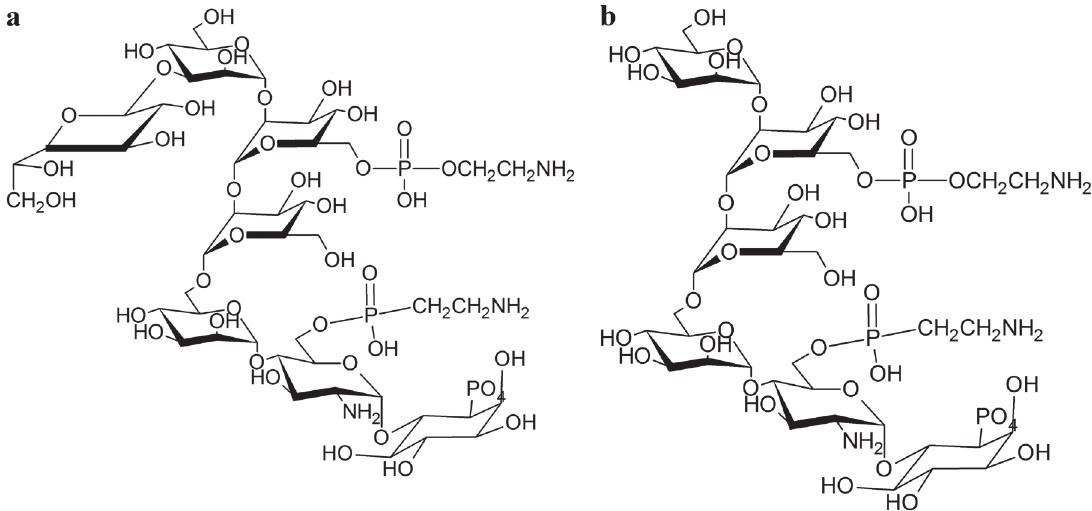
Figure 9 - Representation of PI-oligosaccharide structures isolated from GIPLs of epimastigotes from T. cruzi strain Silvio X10/1.